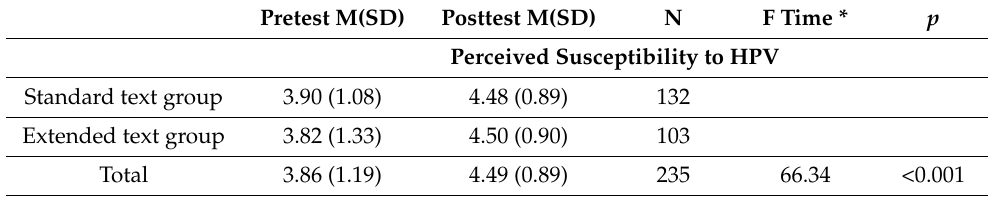
Table 1. Sample-wide effects of reading the texts on perception of HPV